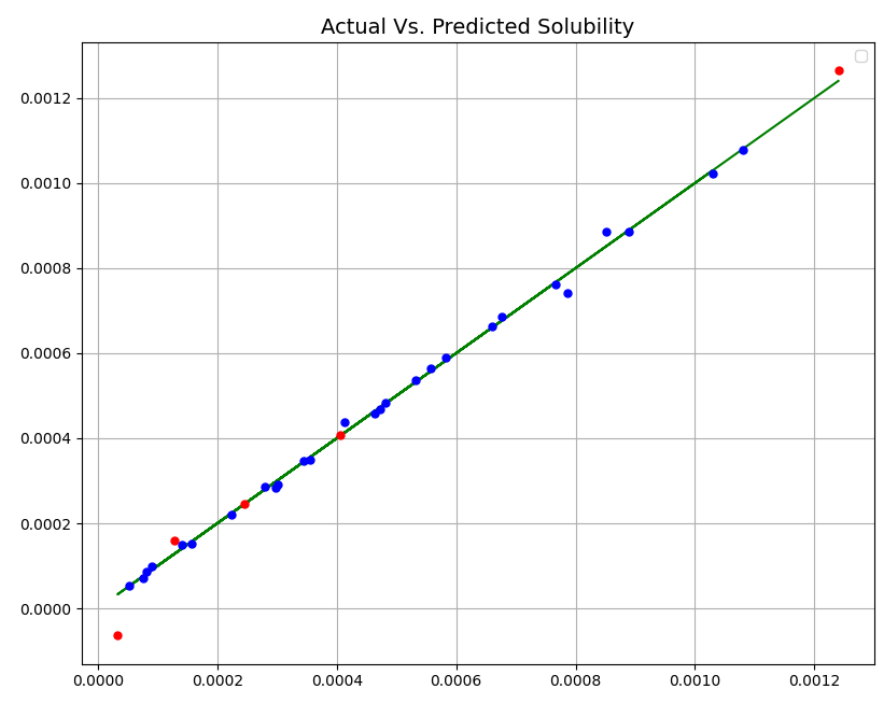
Figure 3. Real Vs. Forestalled Solubility (mole fraction) (GPR).